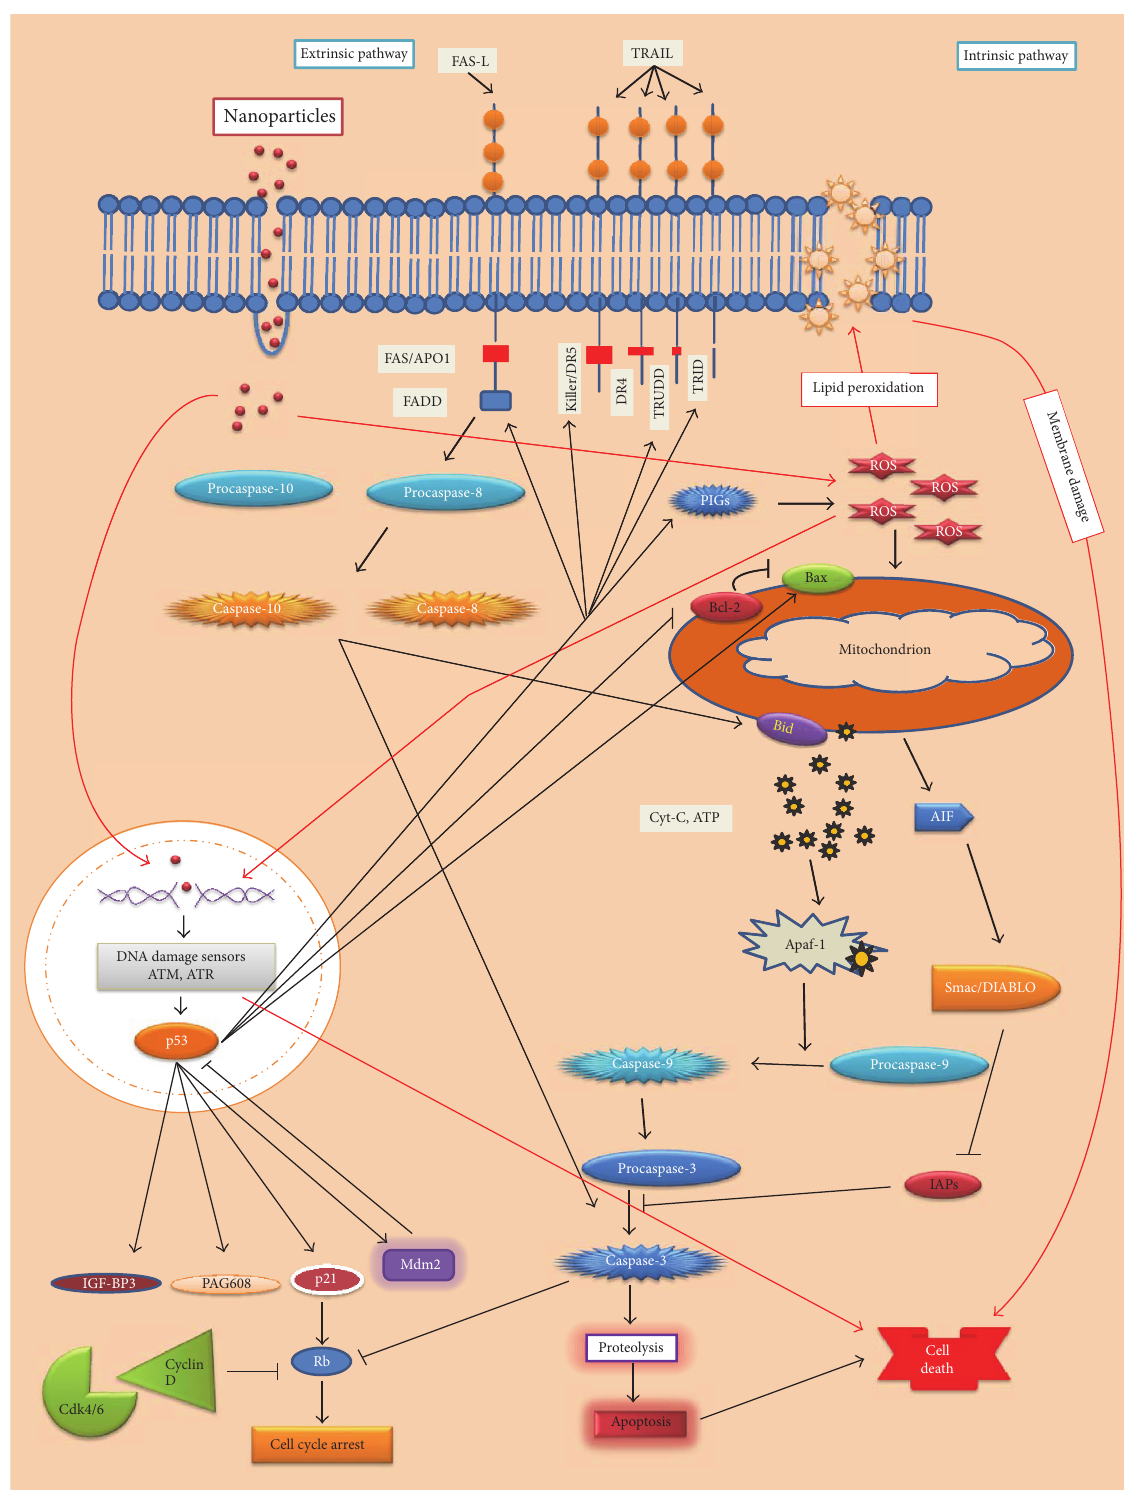
Figure 3: The apoptosis induced by TiO 2 NPs. The TiO 2 NPs-induced apoptosis mostly follows the intrinsic pathway. TiO 2 NPs enter the cell, induce ROS generation, and then enter the nucleus causing DNA damage. The DNA damage is sensed by sensor proteins (ATM/ATR) as a consequence of which p53 is upregulated, which further activates Bax (promoter of apoptosis) and inhibits Bcl2 (inhibitor of